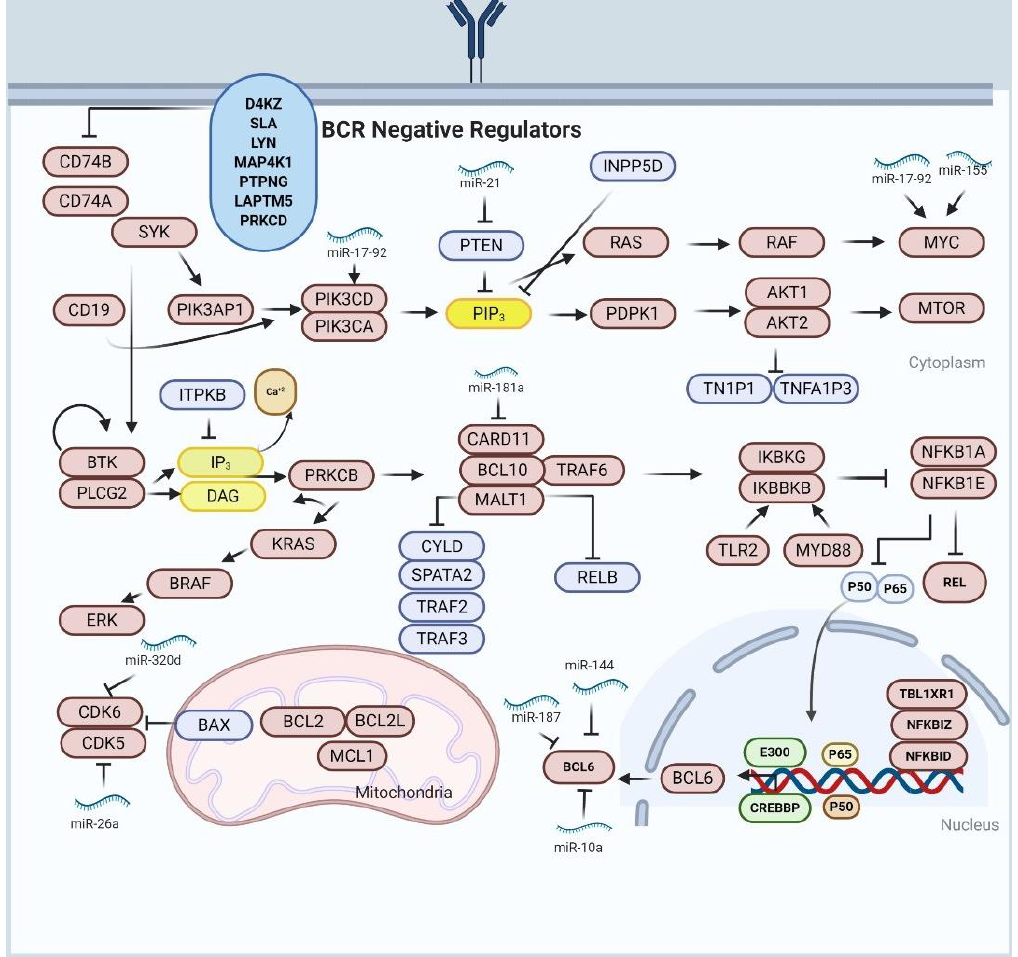
Figure 1. The association of miRNAs and altered signaling pathways in DLBCL pathogenesis. The brown colored proteins are the oncogenes, and the blue colored proteins are tumor suppressors. The oncogenic miRNAs promote upregulation of oncogene or inhibit tumor suppressor activity, conversely, the tumor suppressive miRNAs promote upregulation of tumor suppressor or inhibit oncogenes activity. Both oncogenic and tumor suppressive miRNAs are used as biomarkers for prognosis and diagnosis of DLBCL.